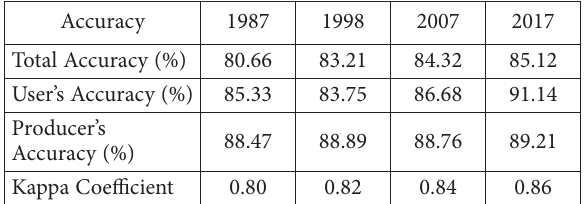
classifier to the Landsat images